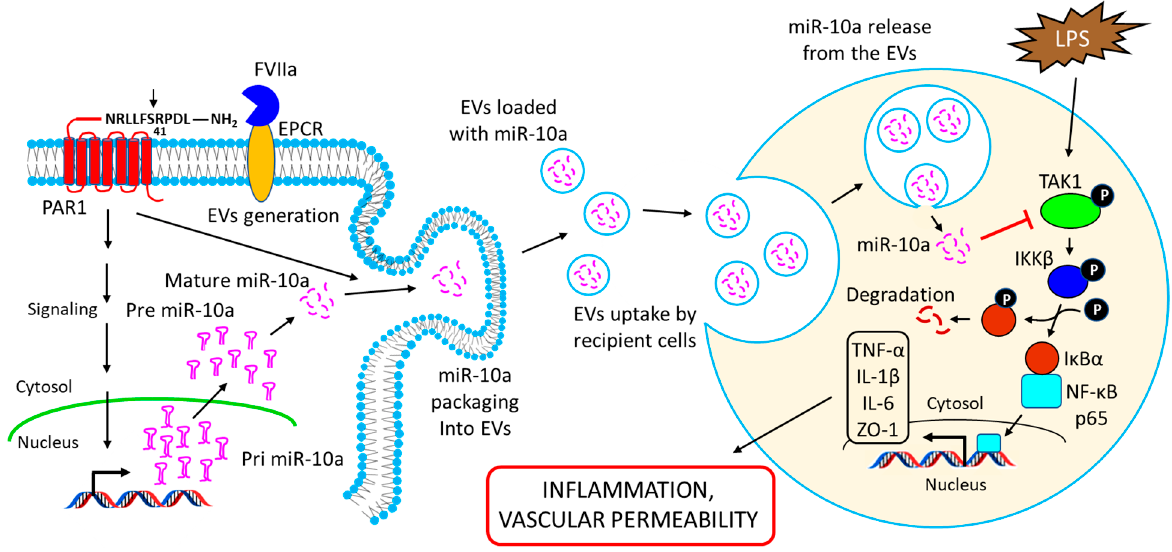
Figure 6. Schematic representation showing the release of miR-10a-loaded EVs from the endothelial cells and their uptake by target recipient cells to alter their phenotypic responses. FVIIa binds to EPCR on endothelial cells and activates PAR1 by proteolytic cleavage at the R41 site. The activation of PAR1 leads to the induction of miR-10a expression in the cells. PAR1 activation also triggers the release of EVs from the endothelial cells, and the FVIIa-EEVs are packaged with miR-10a. The EEVs are taken up by the target recipient cells (such as monocytes or naïve endothelial cells) via endocytosis, and the release of miR-10a from the vesicles into the recipient cell’s cytosol results in the down-regulation of the target gene’s TAK1 expression. TAK1 down-regulation impairs LPS-induced activation of the NF- κ B signaling pathway and the concomitant induction of pro-inflammatory cytokines, TNF- α , IL-1 β , and IL-6, as well as tight junction protein ZO-1, thereby limiting LPS-induced inflammation and vascular permeability in the recipient